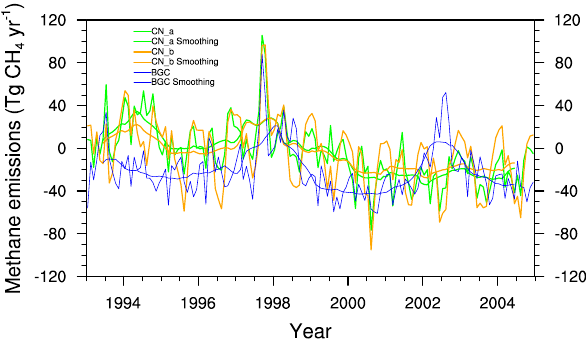
Figure 4. The difference in total emissions used in CN_a, CN_b, BGC experiments as compared with TransCom. A 12-month smoothed average is also plotted for the difference of CN_a (CN_a – TransCom), CN_b (CN_b – TransCom), BGC (BGC – TransCom) with TransCom. Please note that the average of the difference in the period of 1993–2004 is zero.